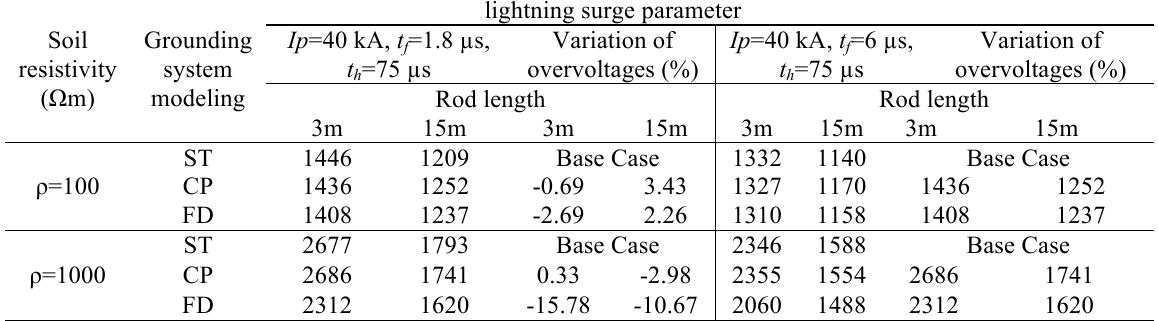
Table 5: Maximum voltage across the insulator string (kV) for Rod-shape grounding system.